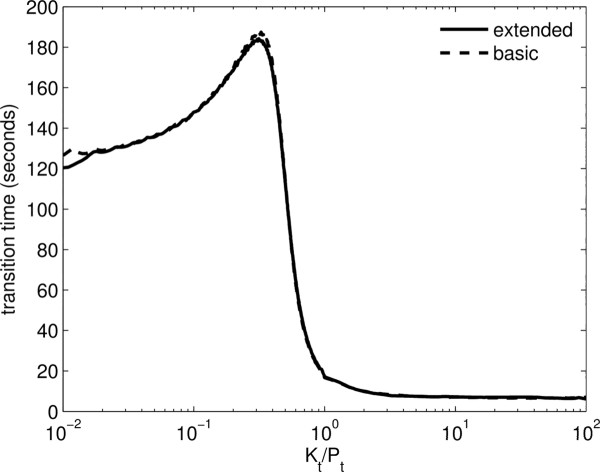
Transient times to approach steady-state for the basic and extended model. Parameter values for the basic model: λ−1 = 10 s−1,λ1 = 1μM−1s−1,k1 = 1 s−1,λ−2 = 10 s−1,λ2 = 20μM−1s−1,k2 = 1 s−1,Pt = 1μM,St = 10μM.Parameter values for the extended model: λ−1 = 10 s−1,λ1 = 1μM−1s−1,k1 = 1 s−1,λ−2 = 10 s−1,λ2 = 20μM−1s−1,k2 = 1 s−1,κ−1 = 50 s−1,κ1 = 1μM−1s−1,λ−3 = 10 s−1,λ3 = 1μM−1s−1,k3 = 100 s−1,Pt = 1μM,St = 10μM.The transient times for R = ([Sp] + [SpP] + [SpPK])/St were estimated such that the absolute difference between the positive steady-state and the time solution at the transient time is within a small tolerance and that the transient times do not change too much if the tolerance is varied. Hence, we chose the tolerance to be 10−4.